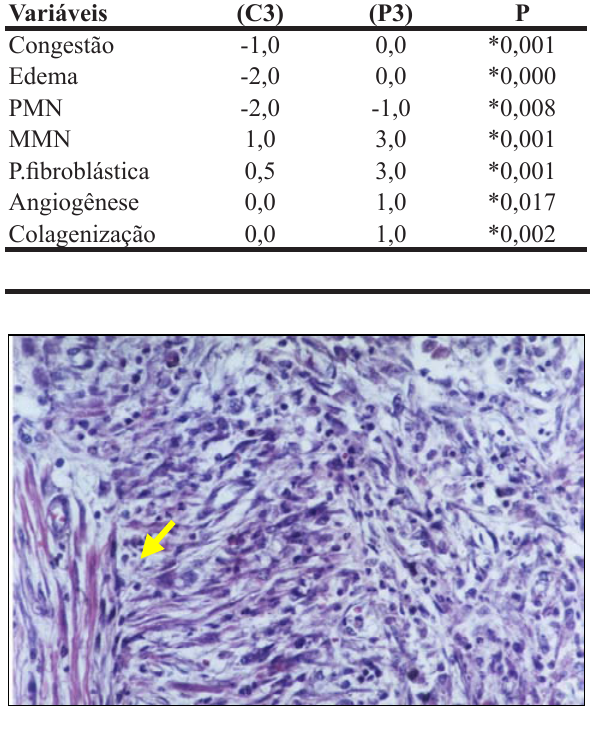
FIGURA 7 – Fotomicrografia de fibrogênese acentuada, animal Passiflora sete dias. H.E, 400x